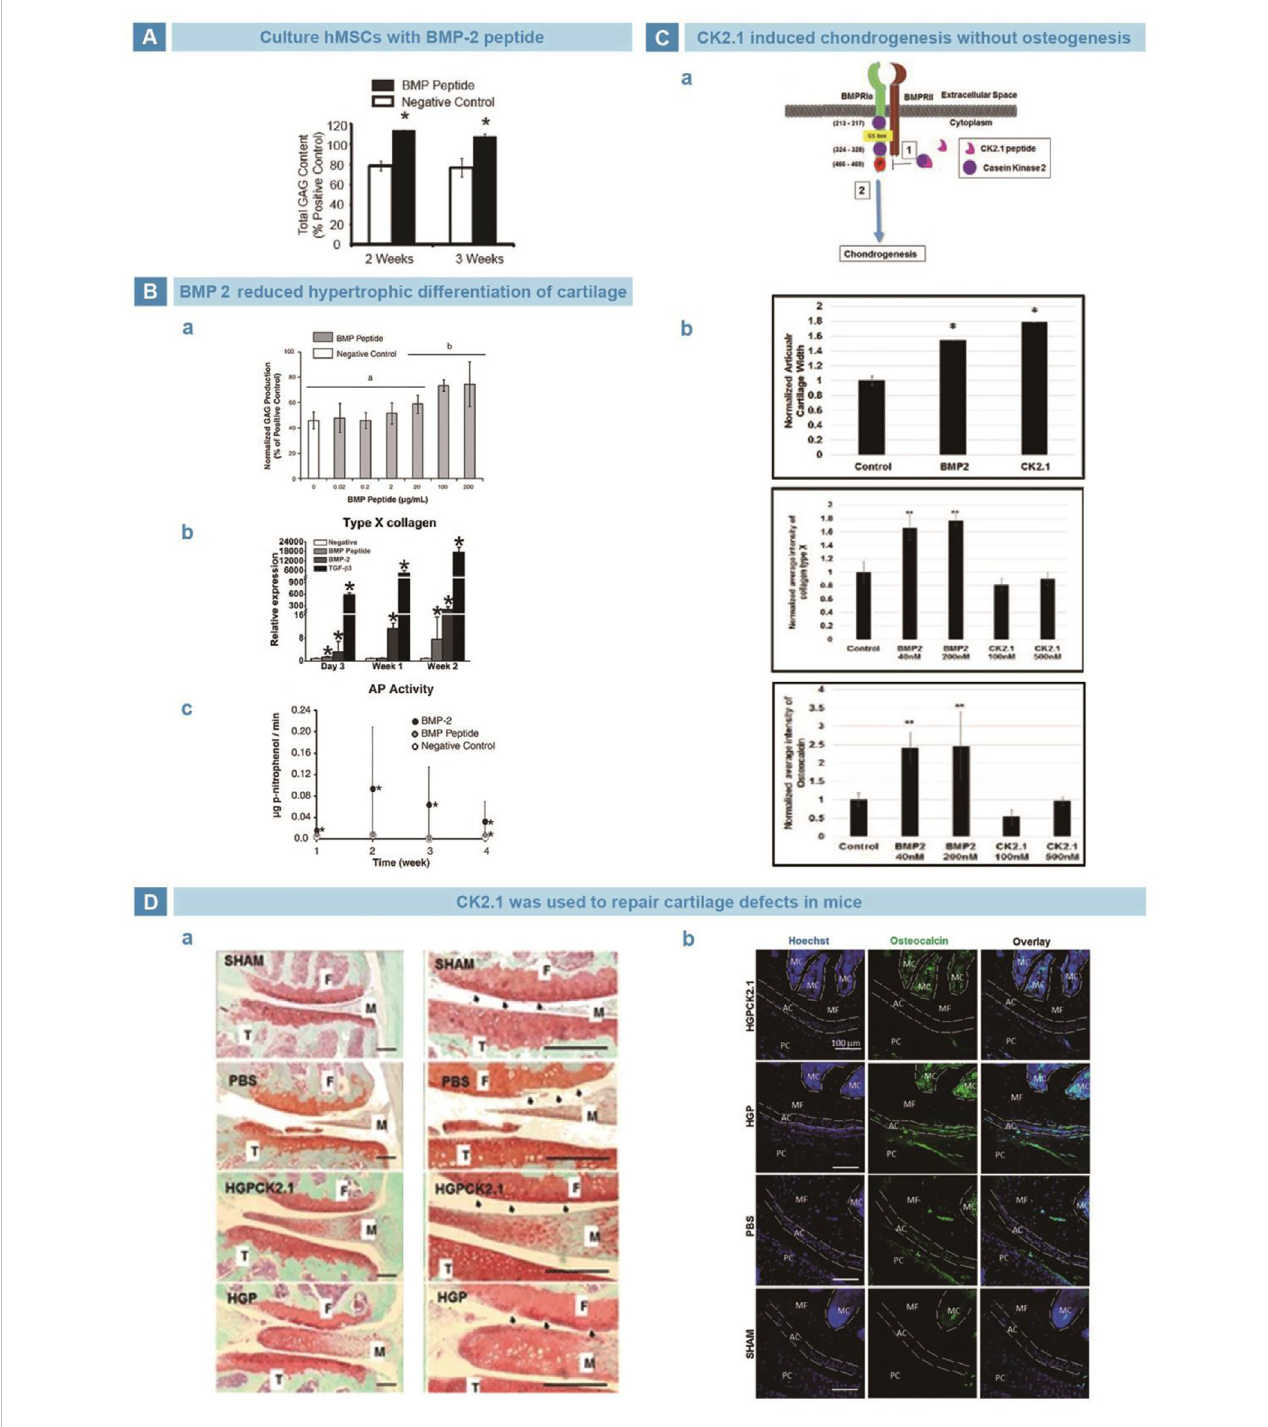
FIGURE 4 BMP-related peptides in cartilage regeneration. (A) . BMP-mimetic peptide signi fi cantly strengthened the secretion of GAGs in hMSCs (Renner and Liu, 2013). (B) . BMP peptide maintained the cartilage structure. BMP peptide did favor for cartilage matrix deposition (A) . BMP peptide reduced the secretion of collagentypeX (B) .BMPpeptidedecreasedtheALPactivityofhMSCs (C) (Renneretal.,2012). (C). MimeticpeptideofBMPreceptortypeI α ,CK2.1,suppressed hypertrophy and ossi fi cation risk of hMSCs. Schematic illustration of CK2.1 (A) . CK2.1 increased the regeneration of cartilage but decreased the expressionofcollagentypeXandosteocalcin (B) (Akkirajuetal.,2017a). (D) .CK2.1-HGPimprovedthecartilagerestorationinmicebutshowednoevidenceof hypertrophy (A) , and lower deposition of collagen type X (B) (Akkiraju et al.,